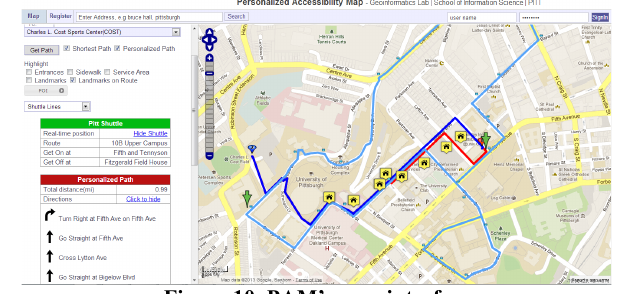
Figure 10. PAM’s user